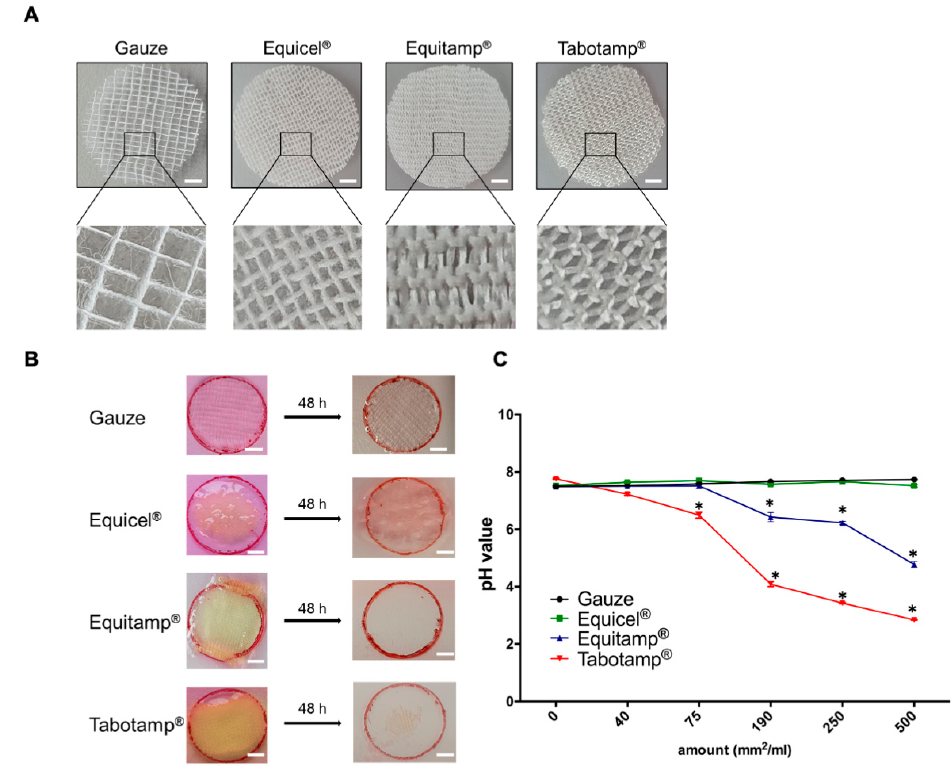
Figure 1. Comparison of ORC properties. Treatment materials with 22 mm diameter. In all experiments gauze served as non-oxidized, non-absorbable control. Gauze and Equicel ® contain frayed organized fibers, which are arranged in a square network structure. Equicel ® is an ORC based on natural cotton and contains collagen and fibrin. Equitamp ® and Tabotamp ® have a woven mesh structure. The viscose-based mesh of Equitamp ® has a higher density compared to Tabotamp ® . Bar = 3 mm ( A ). Samples were wetted with DMEM to compare the dissolution and absorbability. Bar = 5 mm ( B ). The pH values of increasing amounts of gauze or ORC per milliliter supplemented DMEM. The graph shows the mean and SEM of three independent analyses. The significance was tested to the same amount of gauze (* p < 0.001) ( C ).